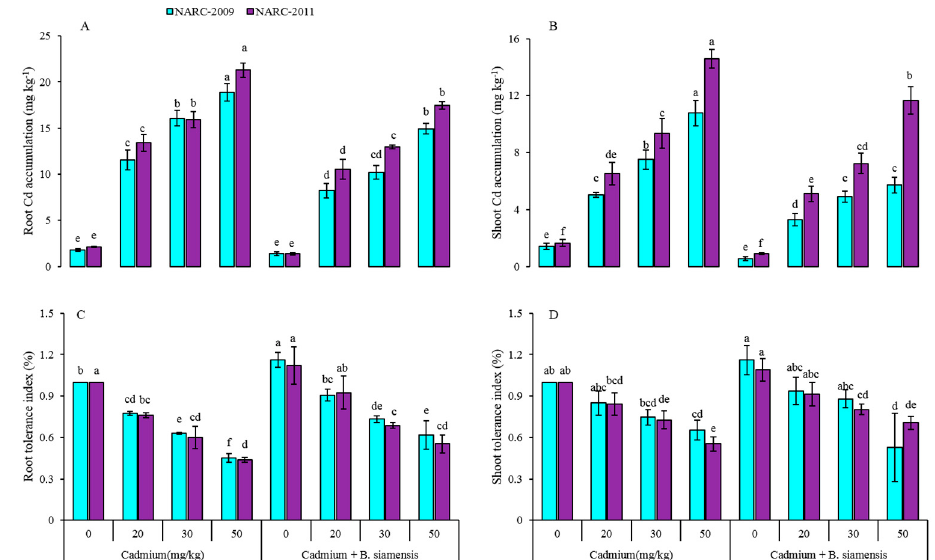
Figure 5. Effect of seed inoculation with Bacillus siamensis on Cd accumulation in root ( A ), shoot ( B ), root tolerance index ( C ), and shoot tolerance index ( D ) of two wheat varieties under Cd stress. Data are expressed as the means of three replicates. Bars show ± SD and different letters show a significant difference among treatments at 0.05 level.